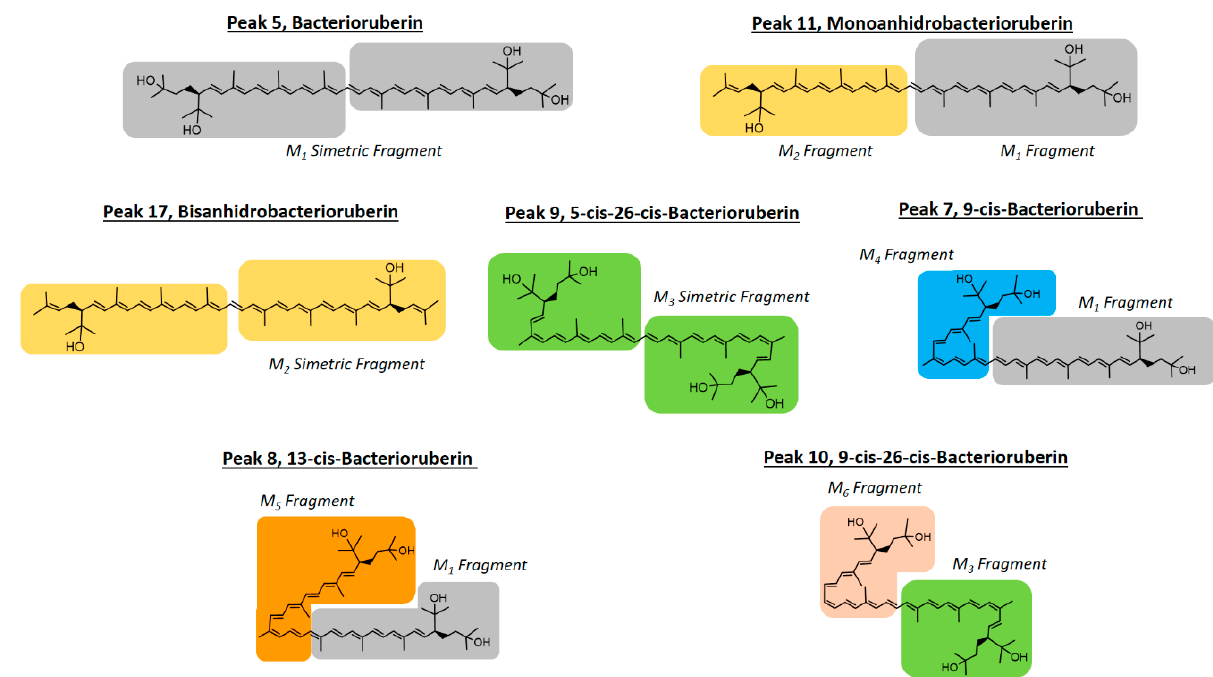
Antioxidants 2021 , 10 , x FOR PEER REVIEW Figure 7. Carotenoids structures found in haloarchaea species and colored fragments tested in docking assays.